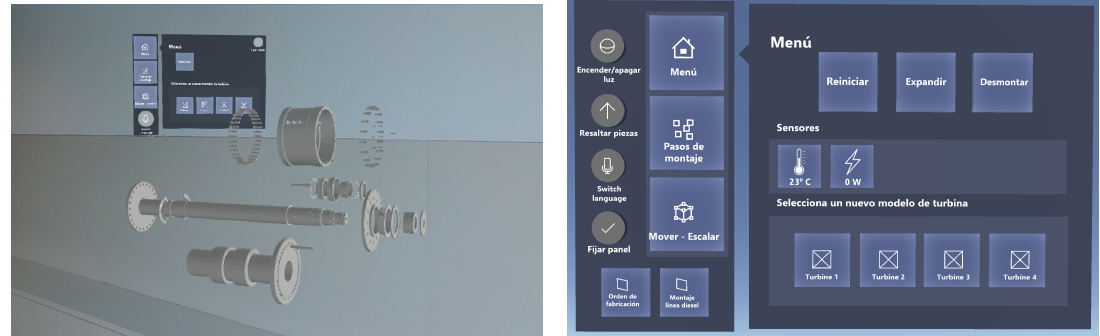
Figure 8. 3D model of the clutch after the disassembly animation ( left ) and a screenshot of the control panel ( right